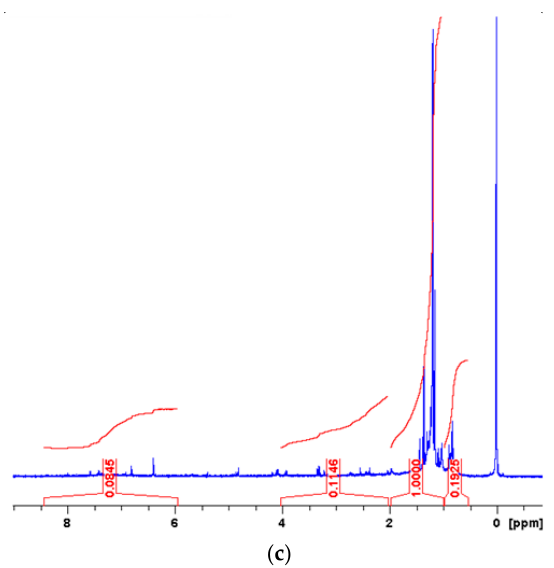
Figure 9. The 1 H-NMR spectra of zone A obtained through a preparative TLC for the three bitumens: ( a ) paving 160/220; ( b ) paving 70/100; and ( c ) industrial 160/220.